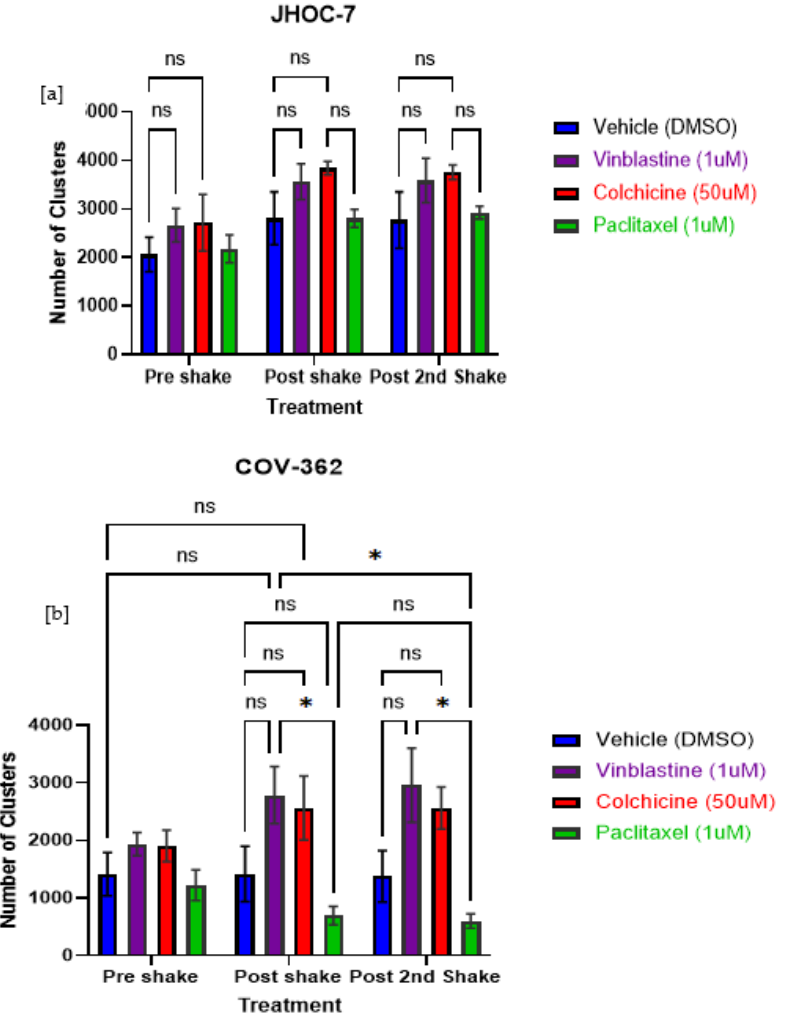
Figure 7. Effect of tubulin depolymerizing and stabilizing agents on ovarian cancer cell aggregation (clusters). Cells were incubated for 18–20 h with drug. The number of clusters formed after two (clusters). Cells were incubated for 18 – 20 h with drug. The number of clusters formed after two 1- min agitations is shown (shake). OSC COV-362, which demonstrates predominantly as a symmetric long phenotype, demonstrated reduced clustering ability (i.e., fragmentation into more numerous aggregates) after treatment with a microtubule depolymerizing agent (vinblastine, cochicine) com- pared to vehicle. OCCC JHOC7, which displays an entirely absent McTN phenotype, demonstrated fewer differences between different drug treatments. This alludes to a role for McTNs in ovarian cancer cell clustering. Mean and standard deviation are shown. Data were analyzed using a two-